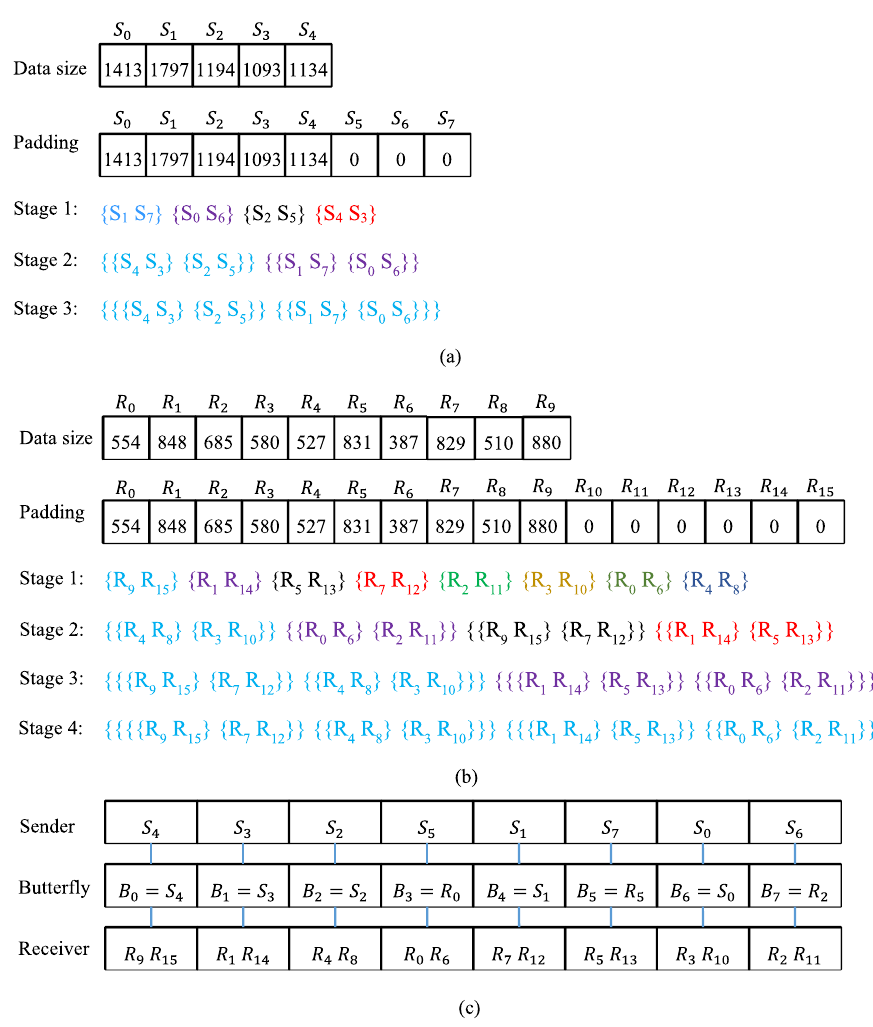
Figure 11. An example of process mappings, given that the sender has 5 processes ( S 0 – S 4 ) , the receiver has 10 processes ( R 0 – R 9 ) (there is no common process between the sender and receiver), and the butterfly kernel contains 8 processes ( B 0 – B 7 ) . Panels (a) and (b) show how to iteratively pair processes of the sender and receiver, respectively. There are multiple stages in the iterative pairing of processes of the sender and receiver. In each stage, the processes in the same colour are grouped into one process pair. Panel (c) shows how to map the reordered processes of the sender and receiver onto the processes of the butterfly